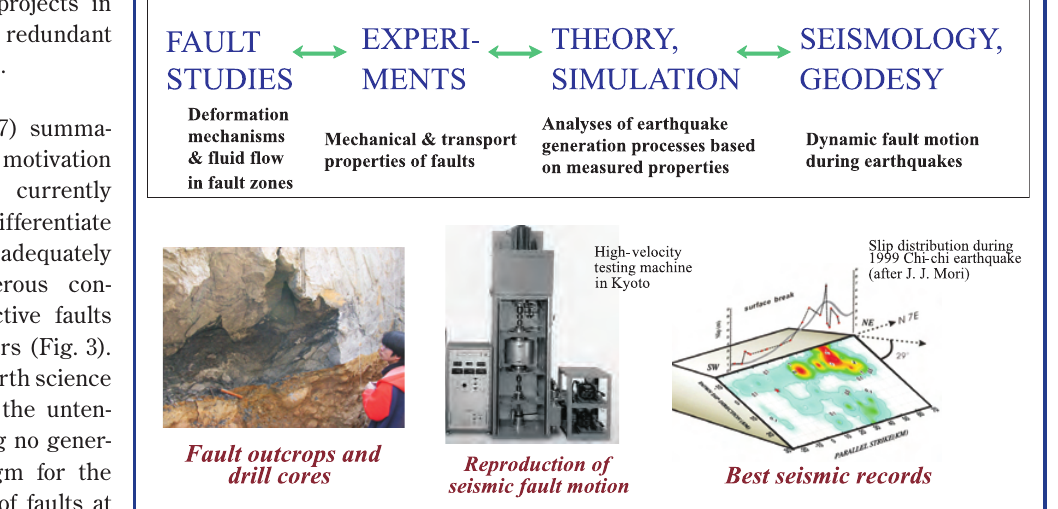
Figure 2. A concept of integrated fault studies in field,laboratory experiment, theory and simulation, and seismic/geo- detic observations on faulting and earthquakes (T. Shimamoto,